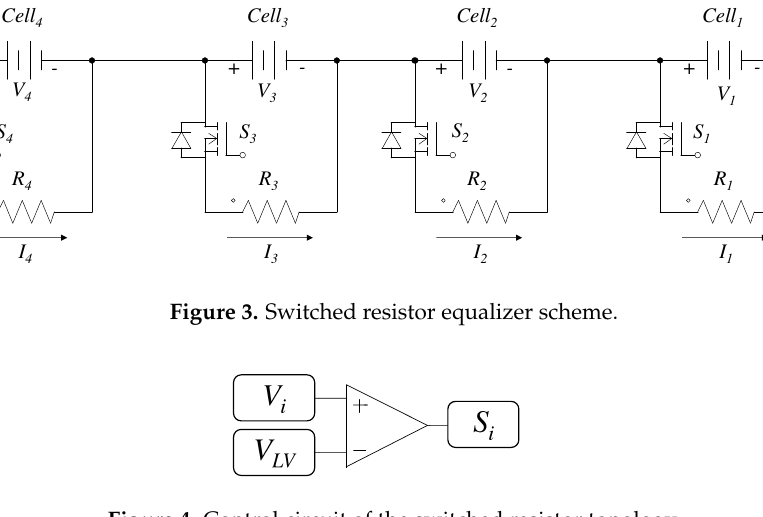
Figure 4. Control circuit of the switched resistor